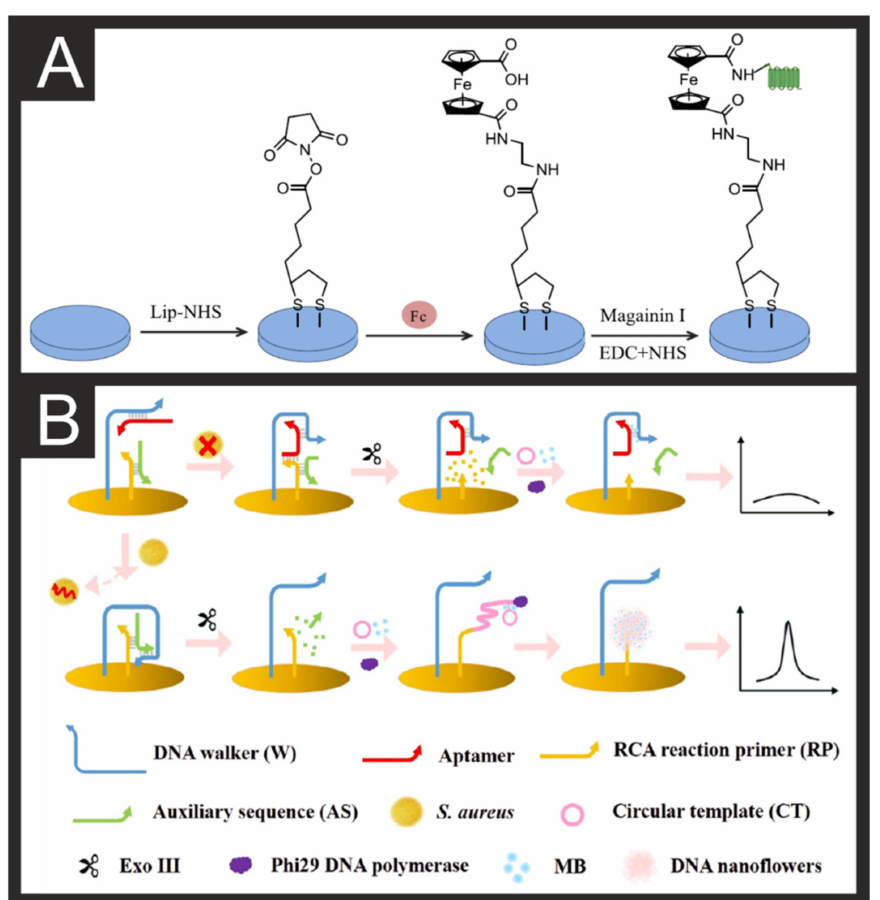
Figure 2. (A ) Schematic diagram for the construction of a ferrocene-peptide-modified biosensor using a gold macro-electrode. Reproduced with permission from [36]. Copyright Elsevier 2014. ( B ) Schematic representation of the DNA Walker and DNA Nanoflower biosensor for S. aureus. Reproduced with permission from [42]. Copyright American Chemical Society